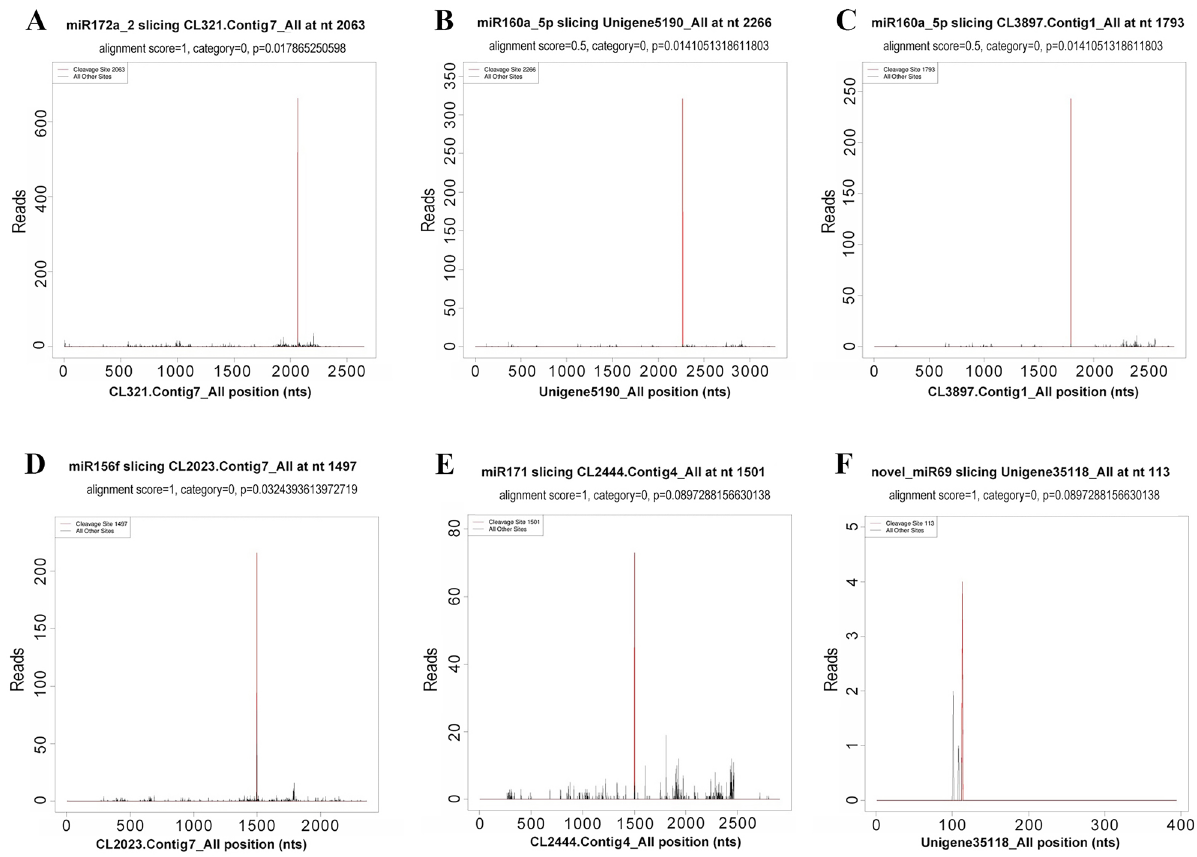
Figure 2. Identification of candidate miRNA targets using degradome sequencing. Six targets of five conserved and one novel miRNAs are shown in the panels as examples. The positions of the target genes are shown on the x-axis, while numbers of sequenced reads are shown on the y-axis. Each line corresponds to a degradome fragment successfully mapped to the corresponding target gene and the red lines indicate the expected miRNA positions. Category 0 indicates that, where the original data fragment was located, the abundance was equal to the maximum abundance of the mRNA, and that there was only one